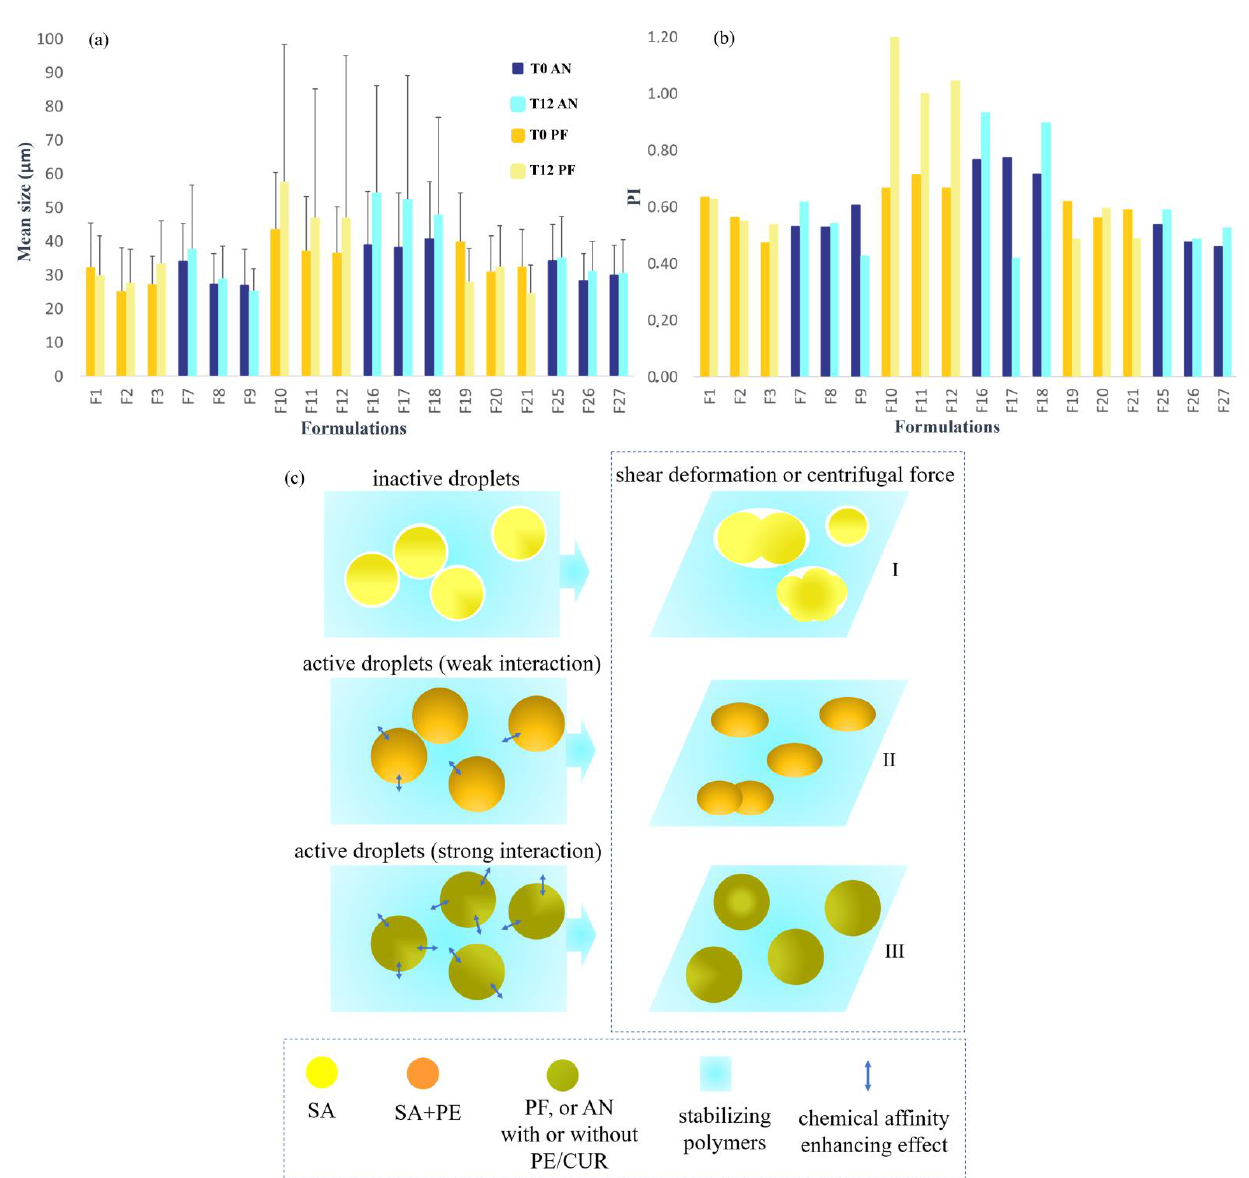
Figure 2. Size analysis of inner phase globules of emulsion systems containing passion fruit (PF) or AN (andiroba) oils just after the preparation (T0) and after 12 days (T12) of the ice-thawing cycles. ( a ) Mean globule size; ( b ) polydispersity index; ( c ) schematic representation of the behavior of different types/compositions of oil droplets relative to the data from size analysis, displaying inactive droplets (I) and active droplets with weak (II) and strong interaction (III).